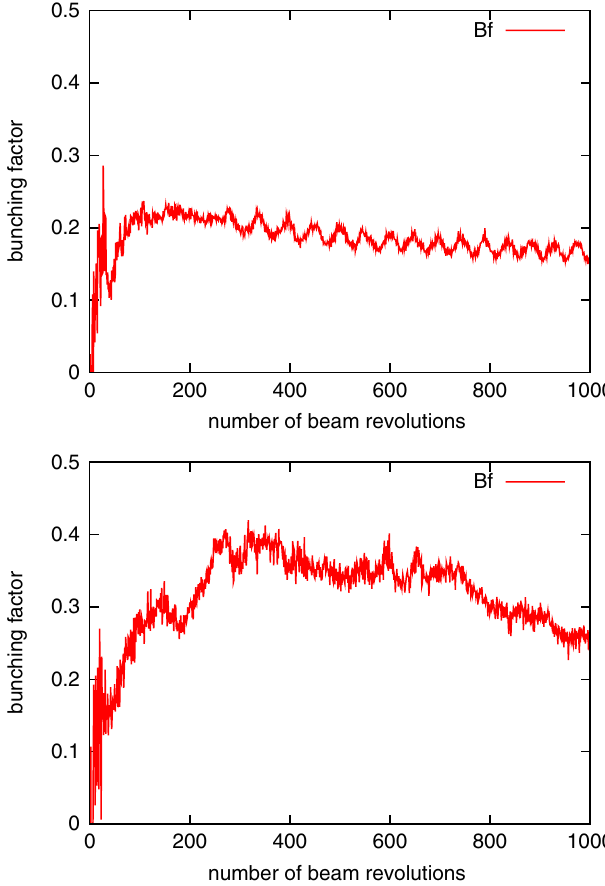
FIG. 11. (Color) Bunching factor plots: (upper) fundamental rf only; (lower) with 80% second harmonic, momentum offset of (cid:1) 0 : 2% , and phase sweep of 80